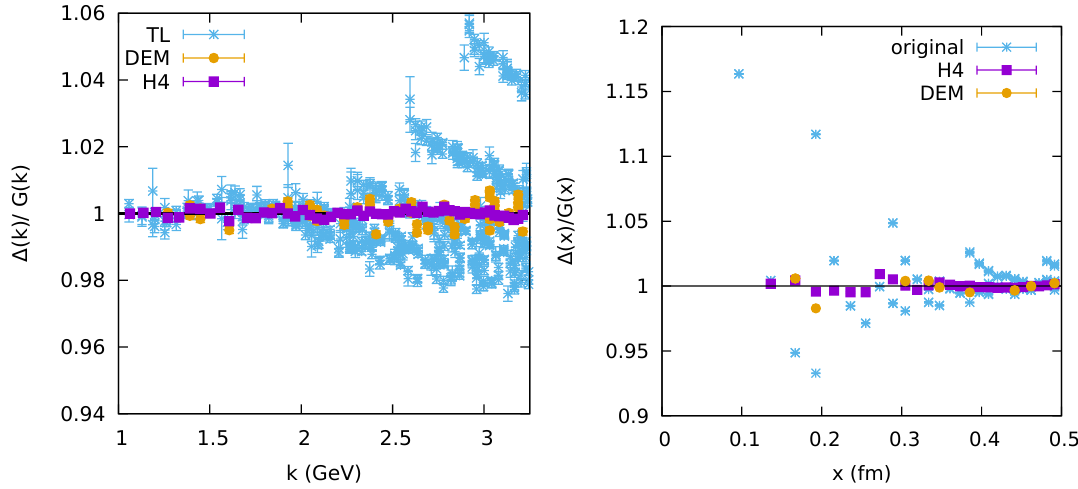
Figure 7. Ratio of the lattice data after treatment of the hypercubic artifacts and the continuum fitting functions in eqs. (5.7), (5.8) for gluon propagator in momentum-space (left) and position space (right). The performance of H4-extrapolation method (H4) compared to democratic method (DEM) and momentum-space tree-level correction (TL) is manifest from the